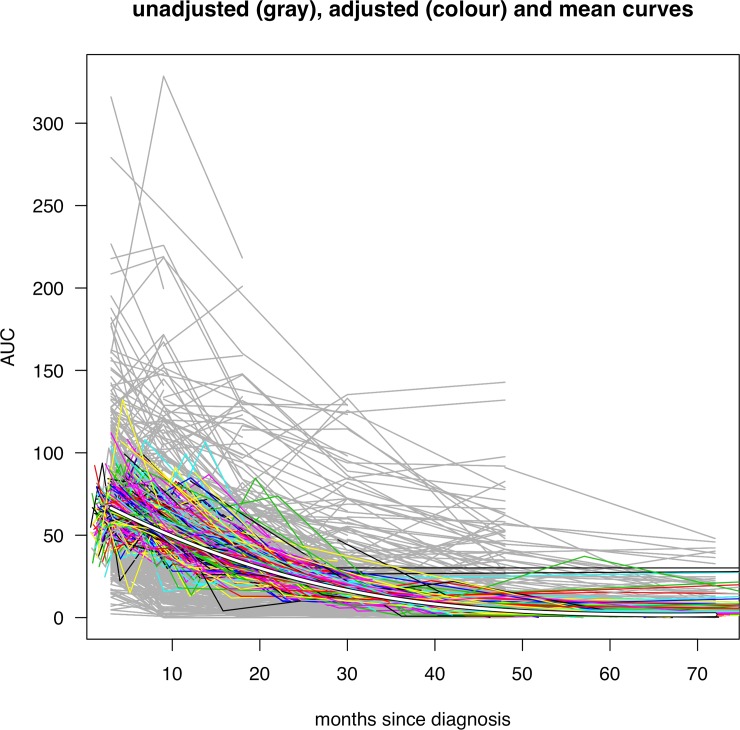
Growth curves of AUC C-peptide for the √AUC model shown unadjusted (gray) and SITAR adjusted (colour), with the mean curve (white).